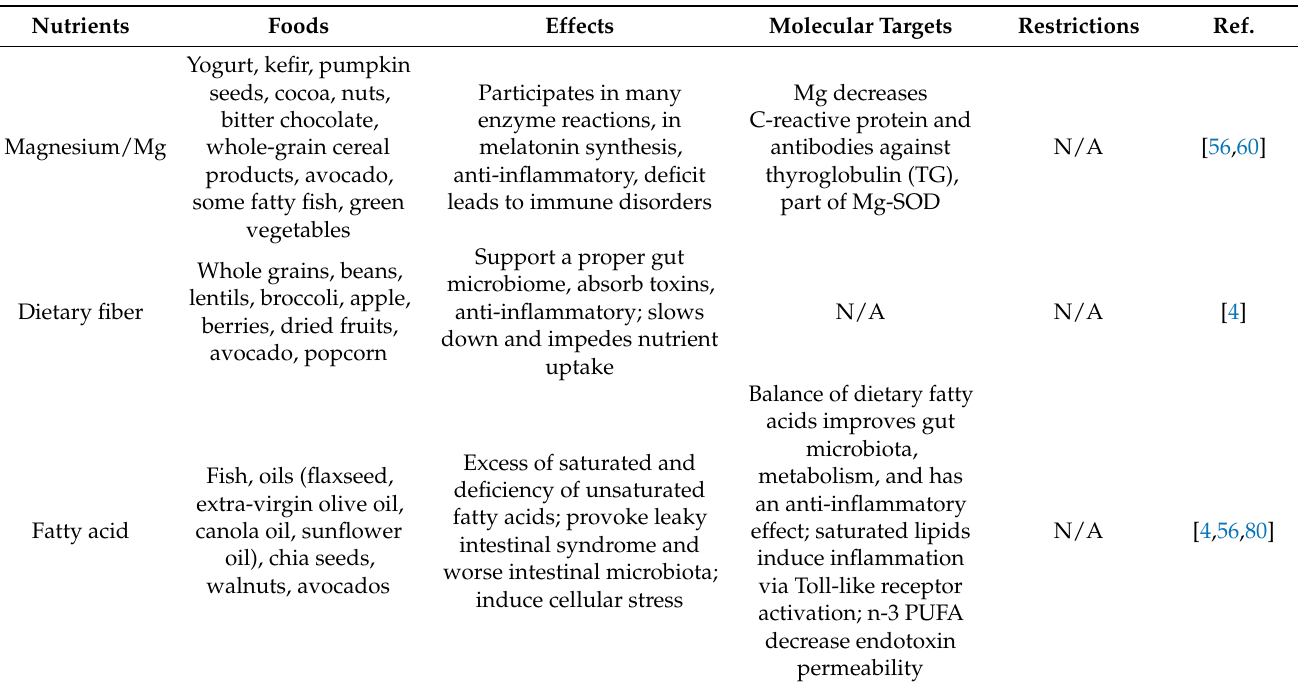
Table 5. Anti-inflammatory